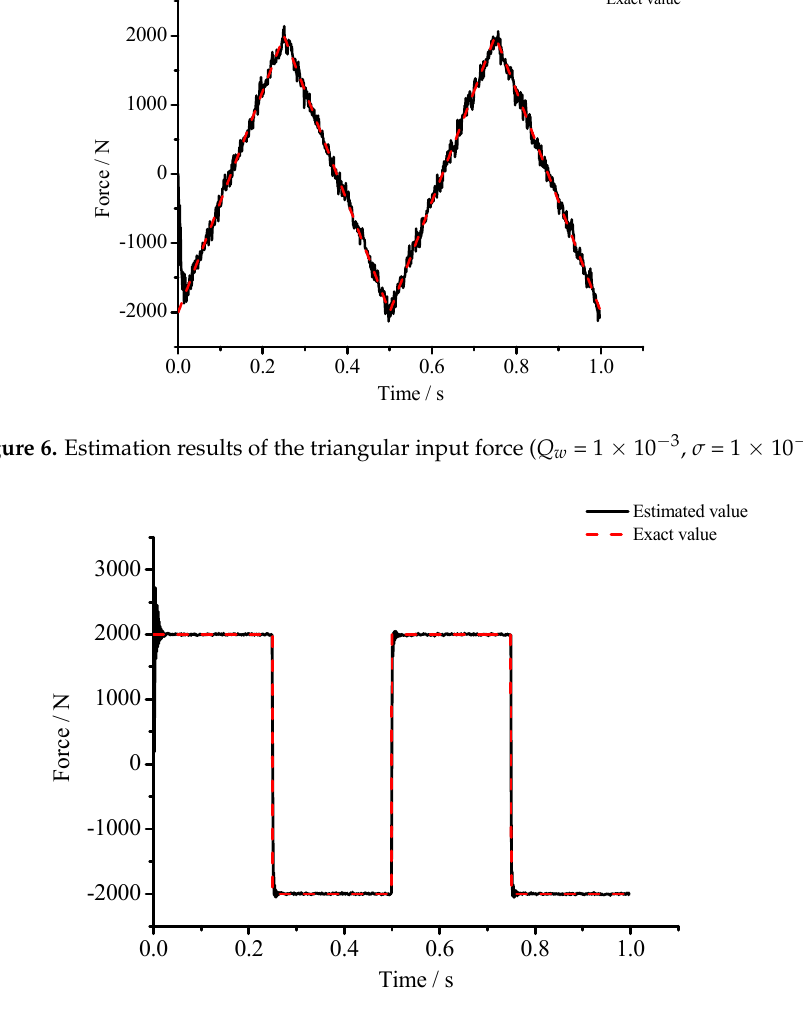
− 4 , σ = 1 × 10 − 8 ). w = 1 × 10